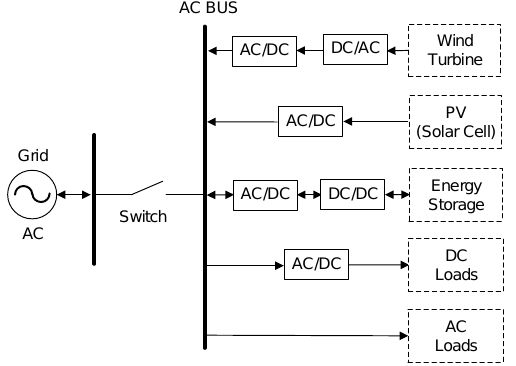
Figure 1. Typical configuration of an AC microgrid.